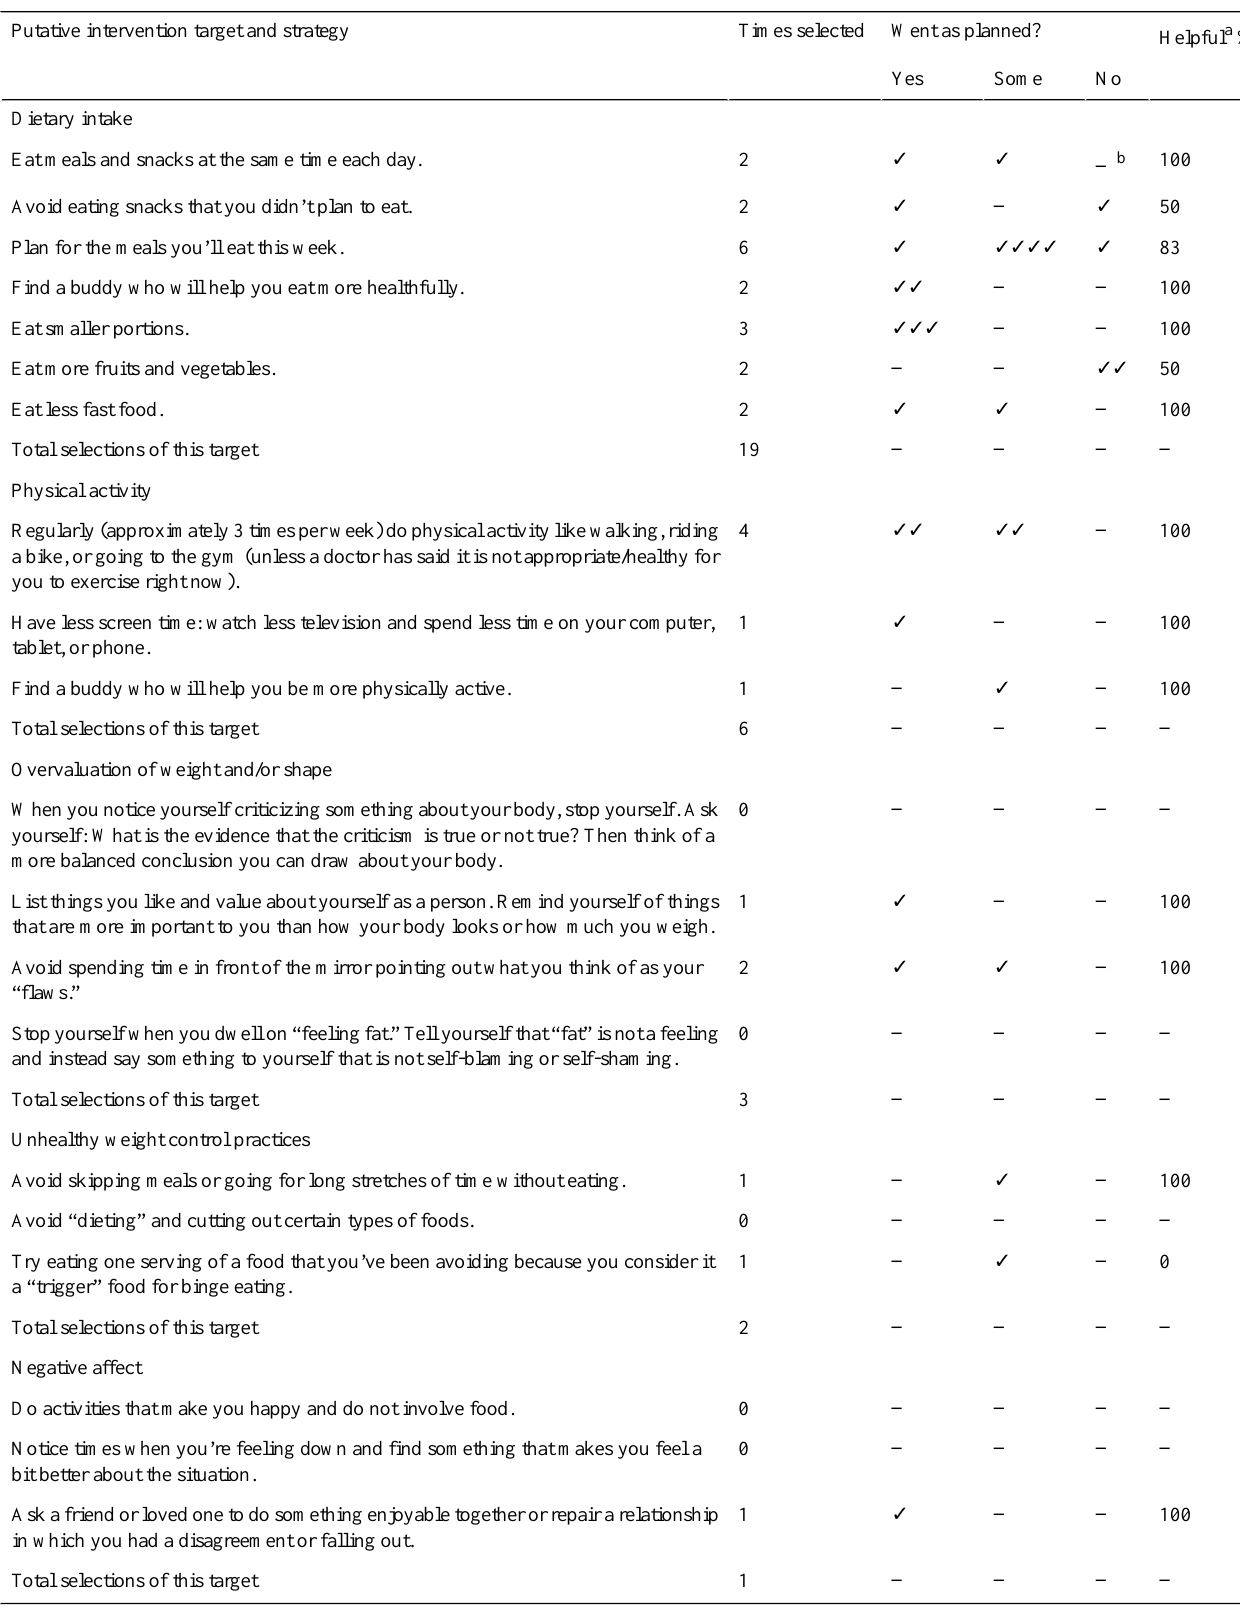
Table 2. Selection of strategies.